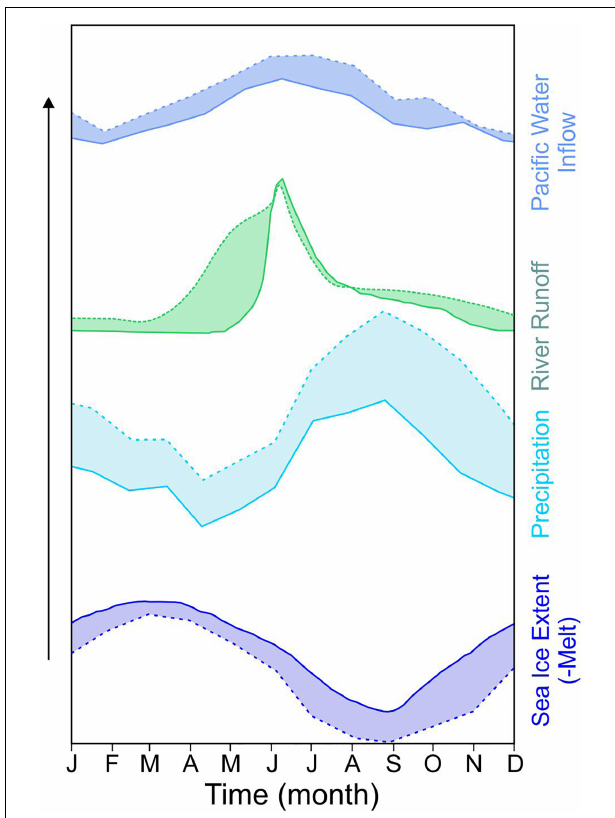
FIGURE 7 | Seasonal impacts of future freshwater change. Predicted seasonal shifts in freshwater inputs to the Arctic Ocean will alter the timing of freshwater delivery to the upper ocean, as discussed in the text (section “Seasonality”). Here, dashed lines and shaded areas indicate the predicted relative seasonal changes with respect to the present-day conceptual representations presented in Figure 4B , following literature cited in Table 3 . Pacific Water inflows (purple shading, top panel) are predicted to increase at least until the mid-twenty-first century, with anticipated increases in virtually all seasons if trends continue to follow mooring observations from the last 25 years. River runoff (green shading, second panel from top) can be expected to increase overall with a seasonal shift to increased discharge in early spring and late fall. Overall precipitation (light blue shading, third panel from the top) is predicted to continue to increase in all seasons, with the largest increases in the autumn and winter months. Sea ice concentration (dark blue shading, bottom panel) is anticipated to decrease in all seasons into the